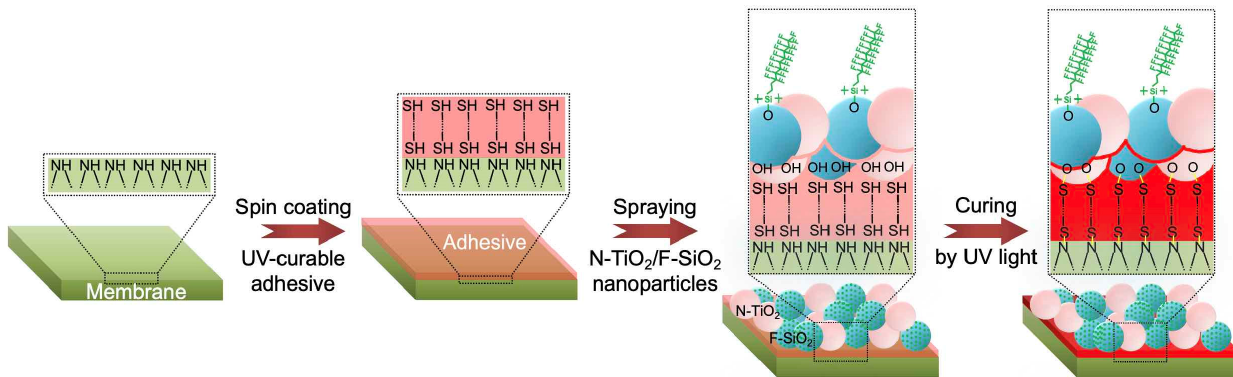
Figure 2. Schematic illustrating the fabrication of a photocatalytic membrane with hydrophilic and oleophobic wettability. A commercial filter is coated with an ultraviolet (UV) light-curable adhesive, followed by being sprayed with a mixture of N-TiO 2 and F-SiO 2 nanoparticles. The membrane was placed under UV light for curing.